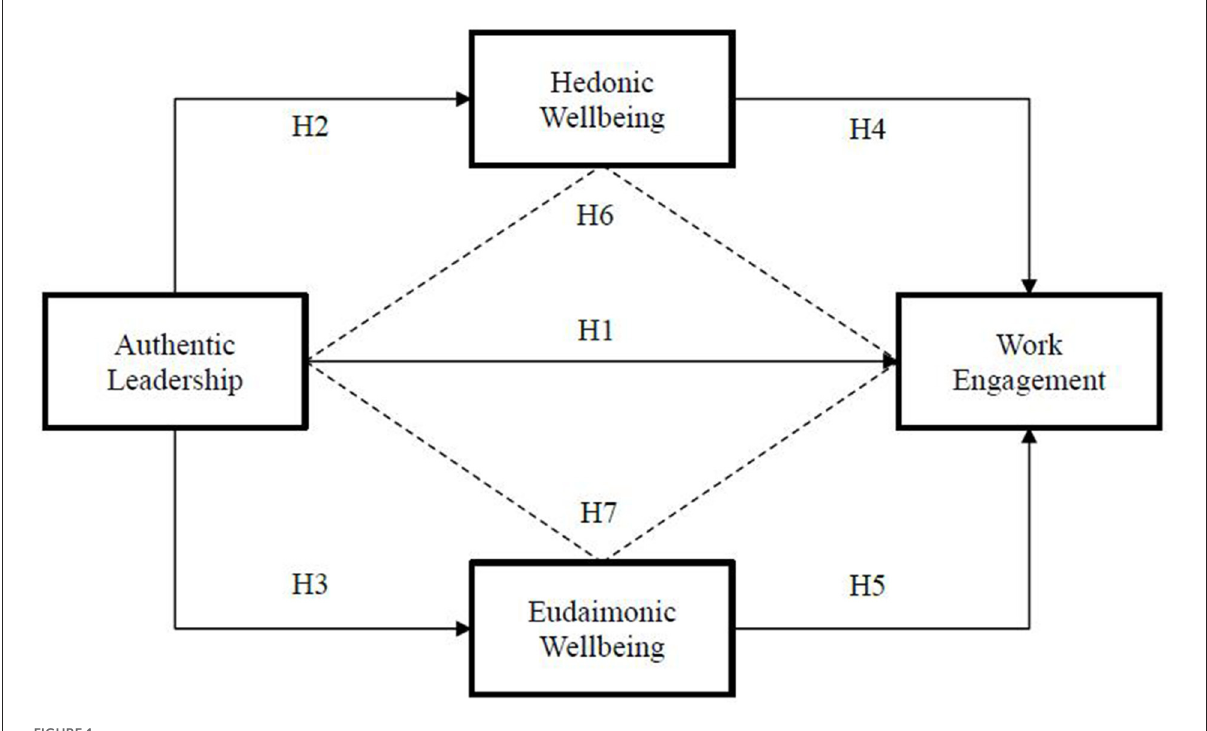
FIGURE1 Proposed research design